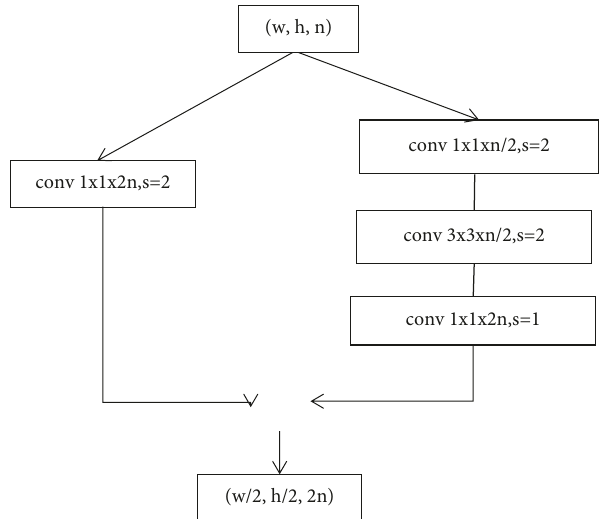
Figure 1: Feature extraction block